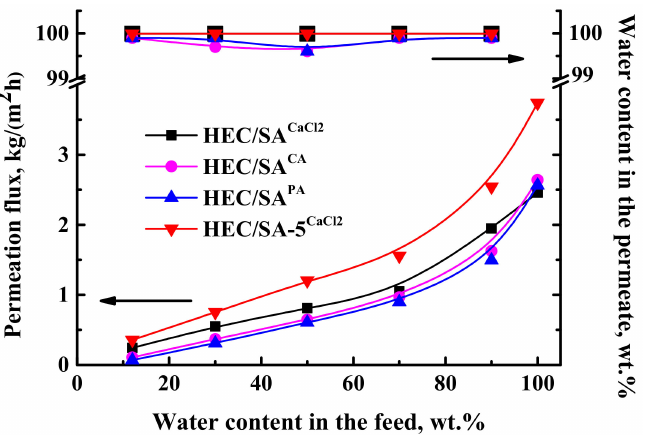
Figure 2. The dependence of permeation flux and water content in the permeate on water content in the feed for the HEC/SA membranes cross-linked with calcium chloride (CaCl 2 ), and phosphoric (PA) and citric (CA) acids, and HEC/SA-5 membrane cross-linked with calcium chloride (CaCl 2 ) in pervaporation dehydration of isopropanol (12–100 wt.% water) at 22 ◦